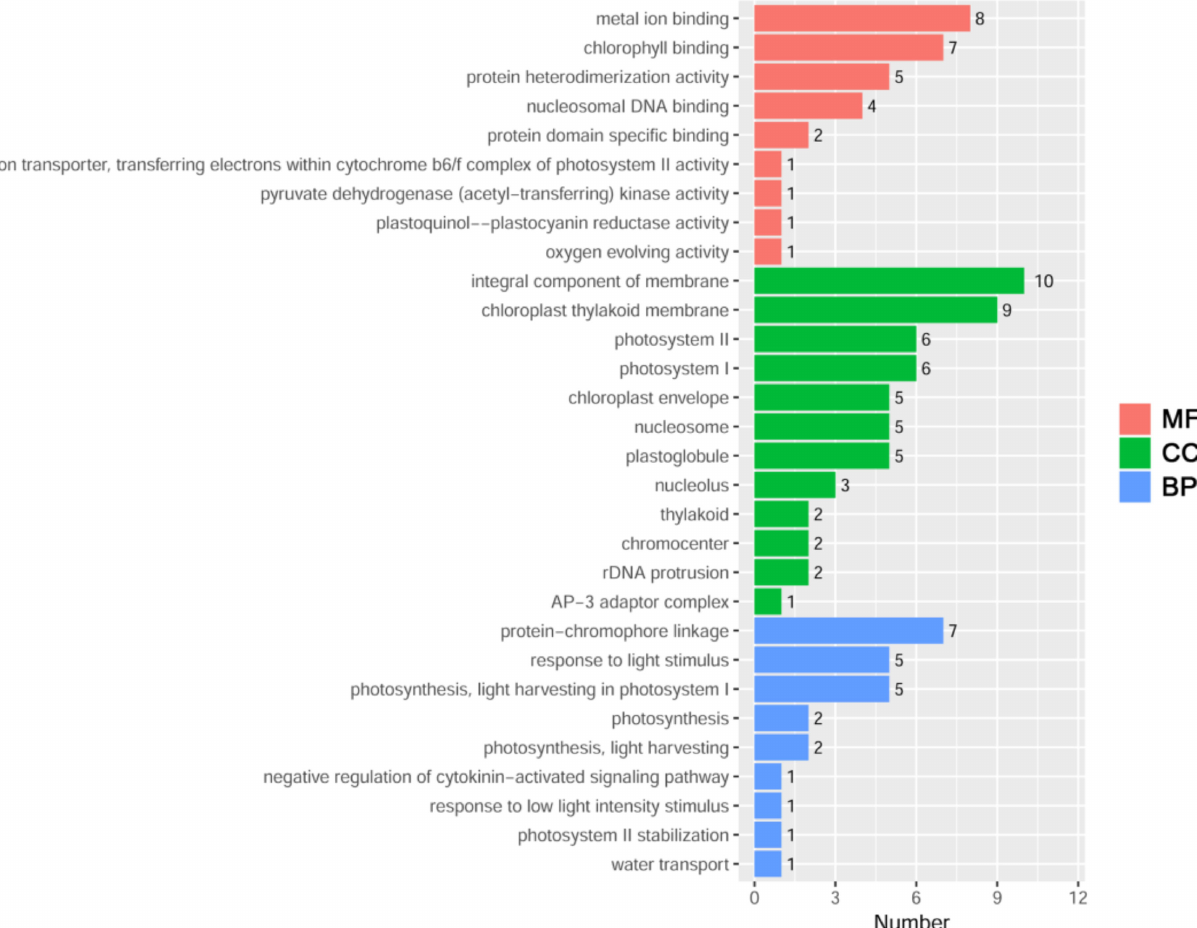
Figure 9. GO enrichment analysis of the 28 screened upstream regulatory factors of ZmDi19-5 .The 30 most significant GO terms are shown in the figure. MF, molecular function; CC, cellular component; BP, biological